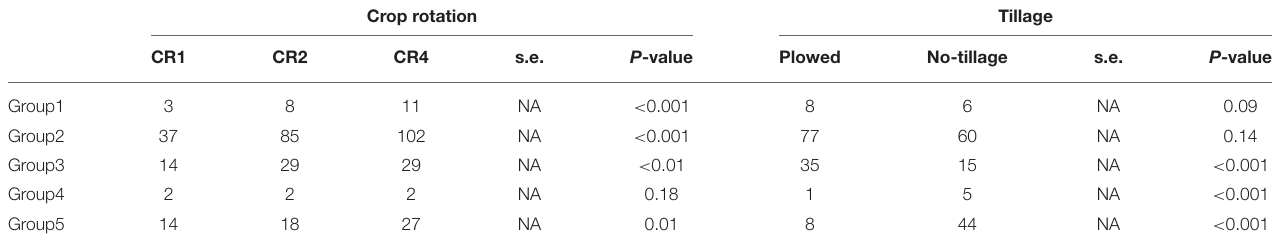
TABLE 6 | The average density of weeds (plants/m 2 ), in spring wheat in different weed groups, tillage systems, and crop rotations. Crop rotation